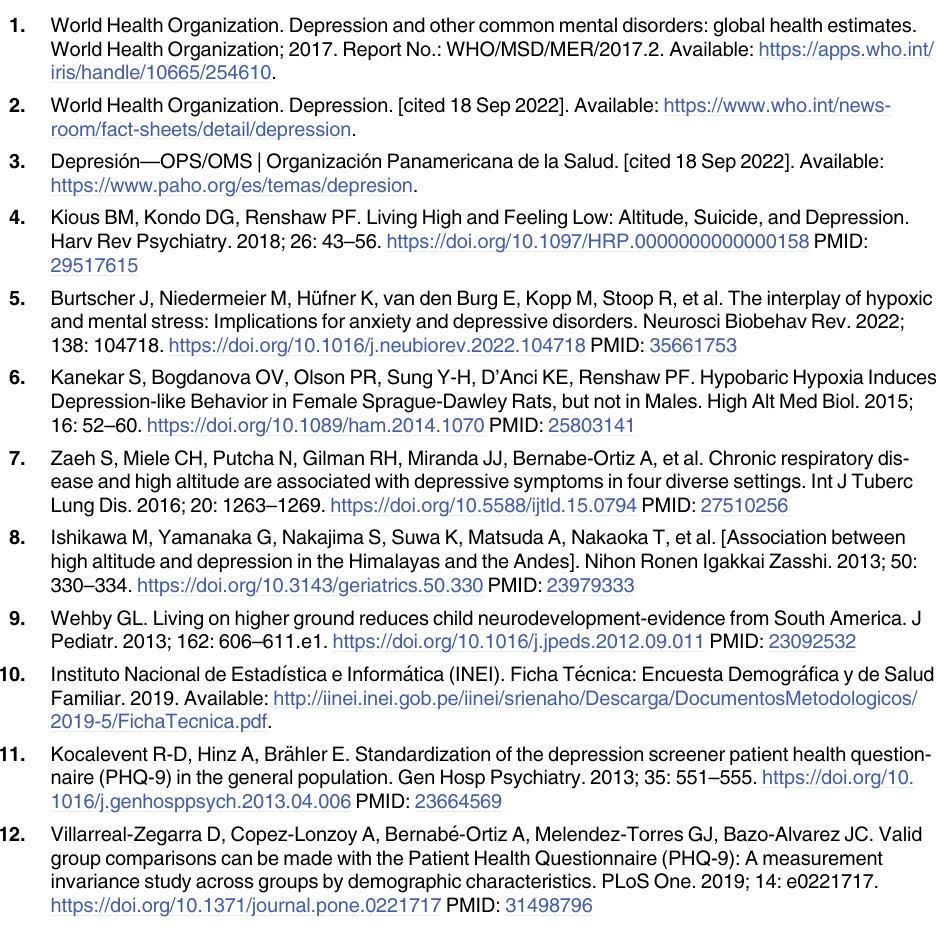
S4 Table. Stratification by ethnic group for comparison of adjusted prevalence ratios of depressive symptoms according to